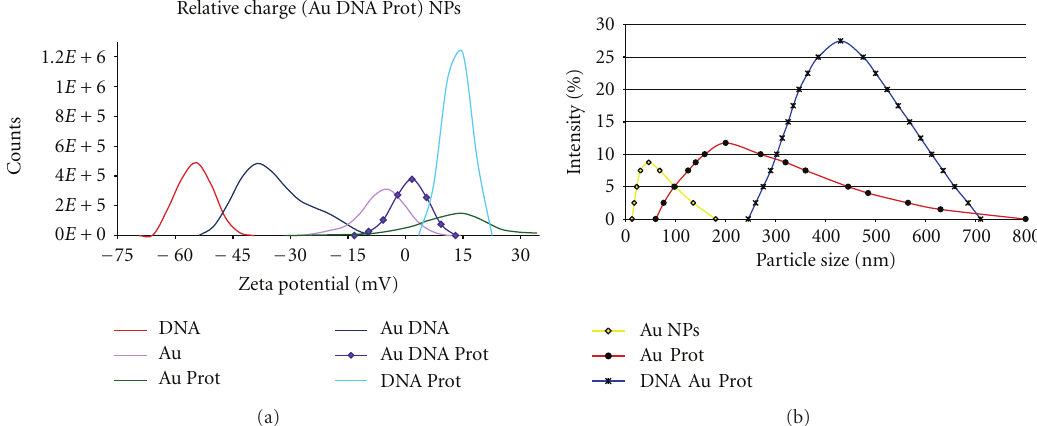
Figure 8: Evidence for bionanoconjugates made between GNPs, protamine, and DNA by DLLS analysis of (a) surface charge and (b) size distribution by intensity.